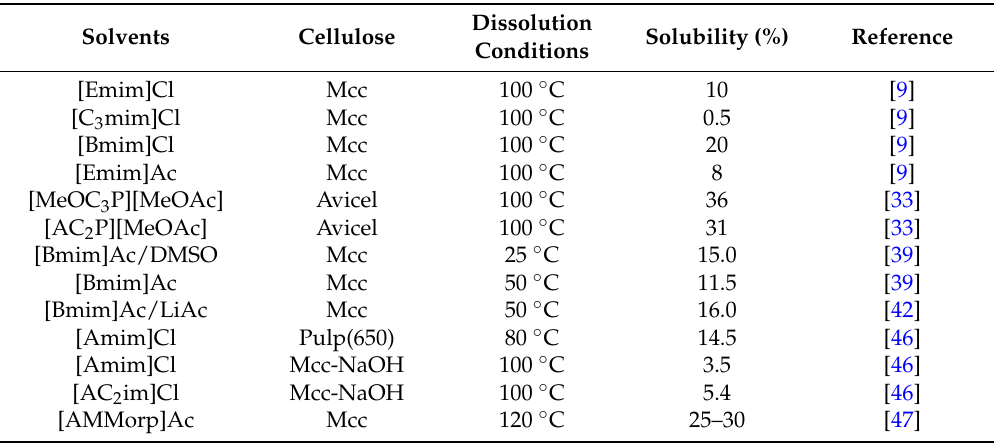
Table 1. Solubility of cellulose in ILs and IL-based solvent